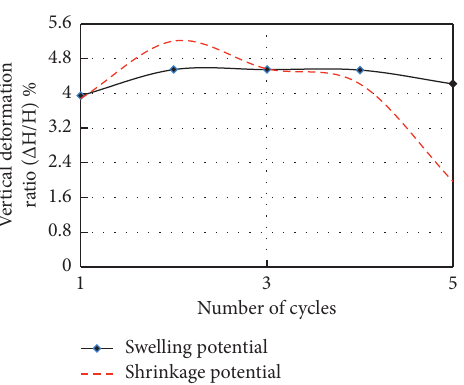
Figure 7: Swelling/Shrinkage potential versus the number of cycles for